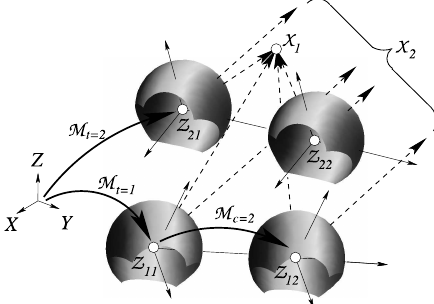
Figure 1: A two-camera system with Fisheye cameras c = 1 , 2 with projection centers Z tc and known motion M c and